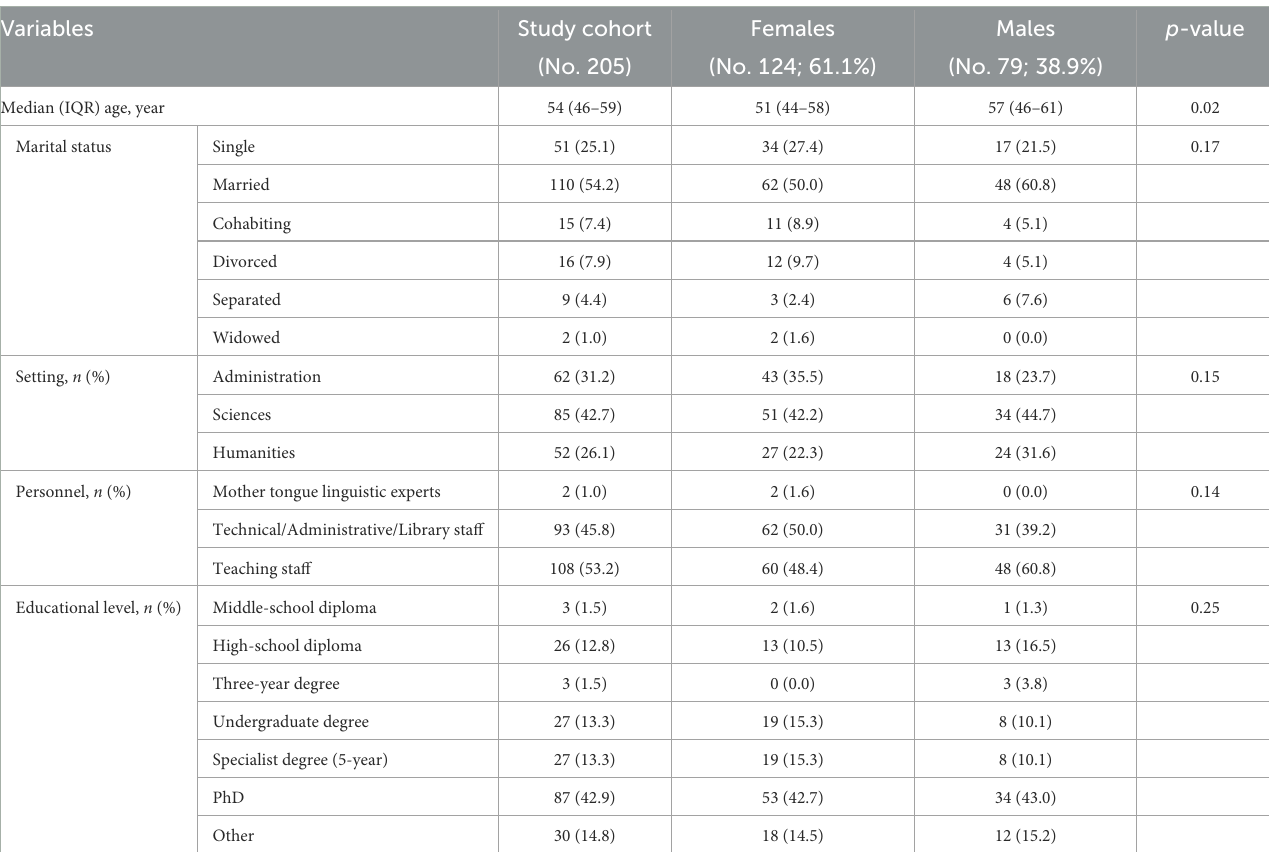
TABLE 1 Participants’ socio-demographic characteristics.